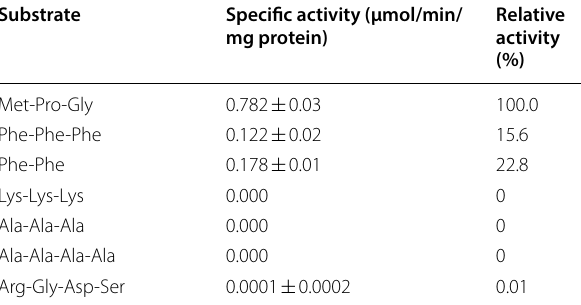
Table 1 Hydrolysis of synthetic peptides by XPO